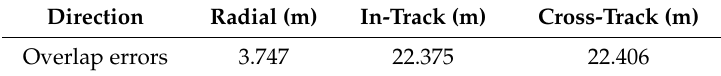
Table 7. Orbit overlap differences of